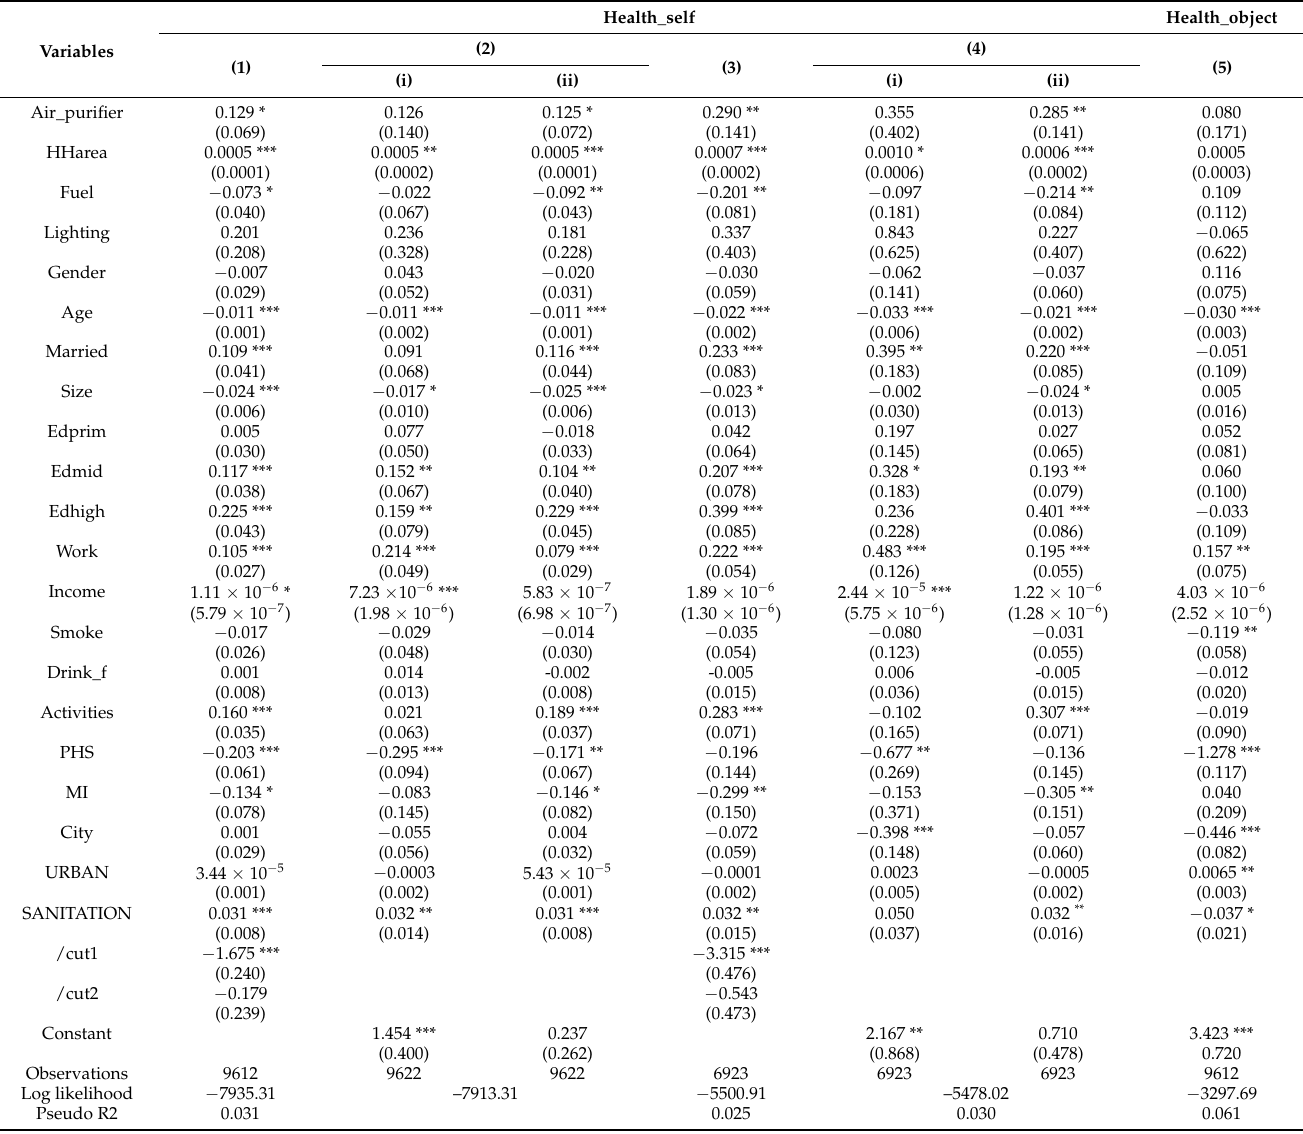
Table A1. Robustness check of the effect of indoor air purification on residents’ self-rated